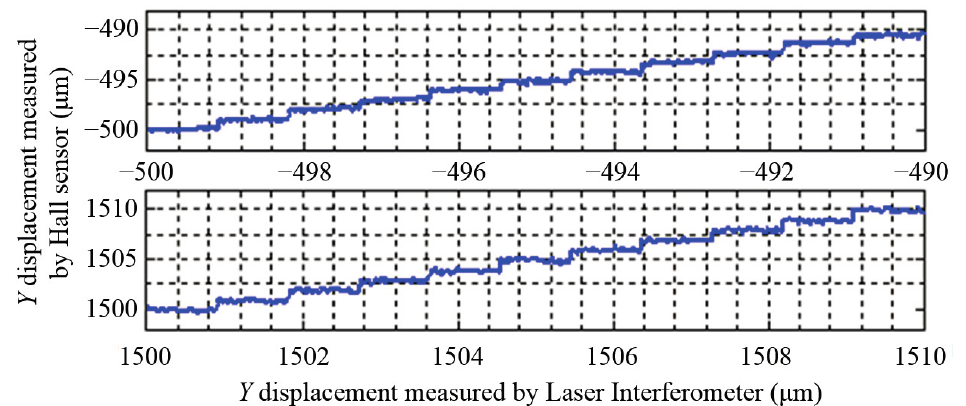
Figure 16. The resolution of the Hall sensors in Y direction.